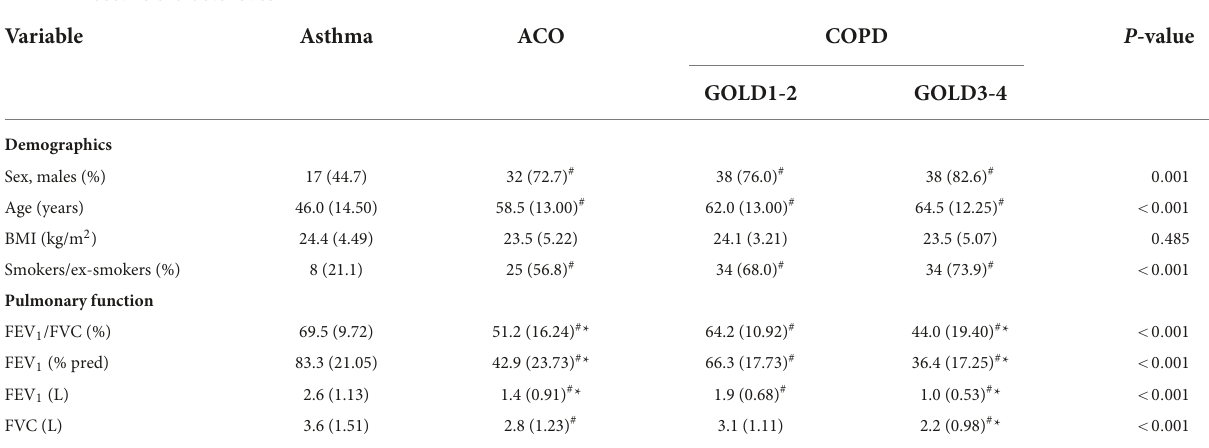
TABLE 1 Baseline